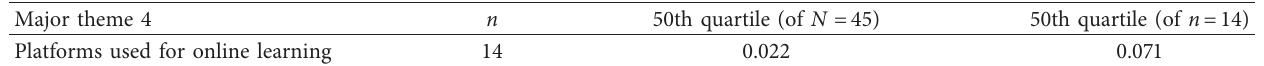
Table 9: 50th quartiles for platforms used for online learning.